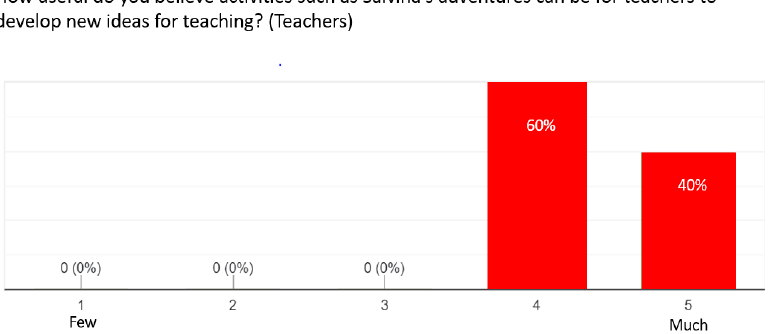
Figure 9. Cumulative values showing percentage of the feedback received for the third question from teachers, concerning all the played Salvina’s adventures.